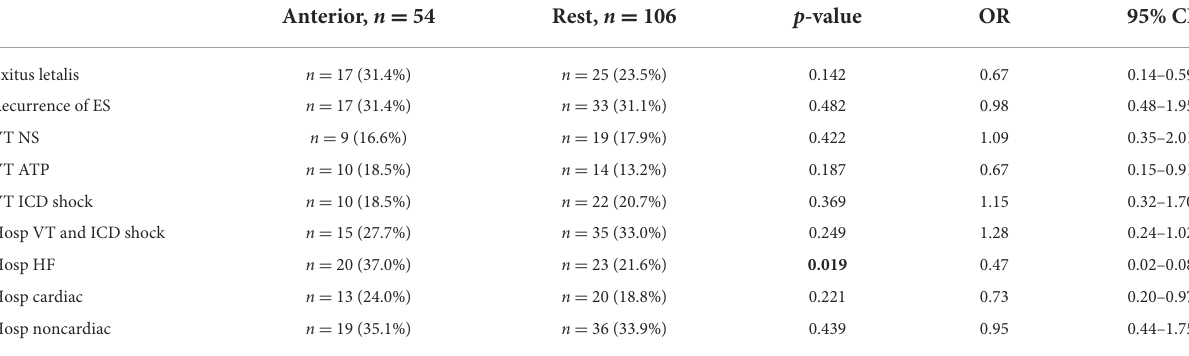
TABLE 6 Analysis between scar localization; anterior vs. the